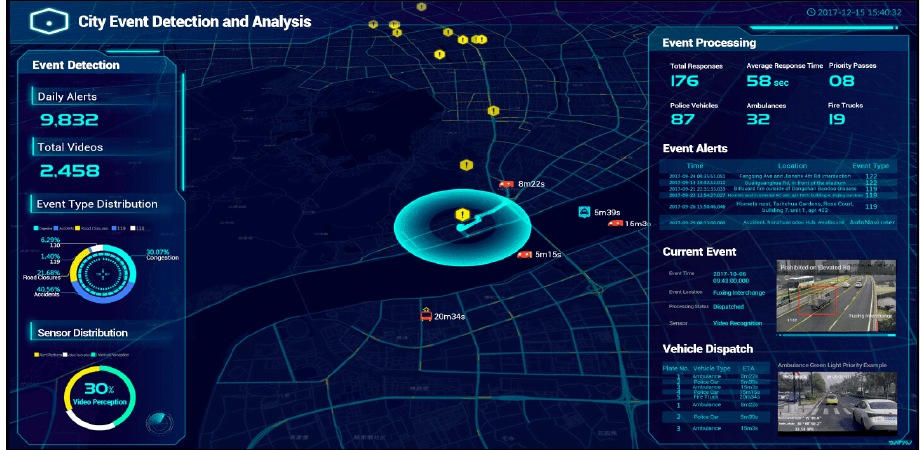
Figure 5. Alibaba City Event detection and smart processing, derived from [145].